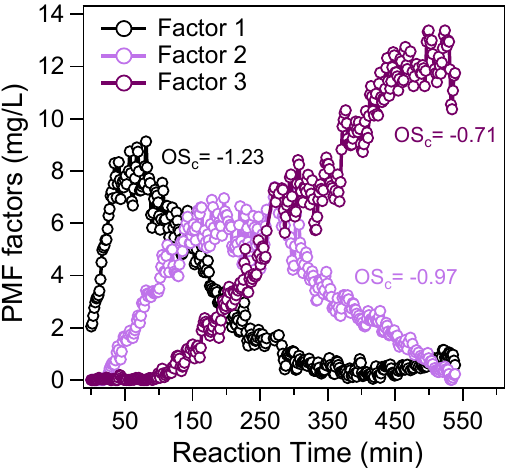
Figure 6. Temporal variations of the positive matrix factorization (PMF)-resolved factors during the course of OH-mediated photochemical oxidation.